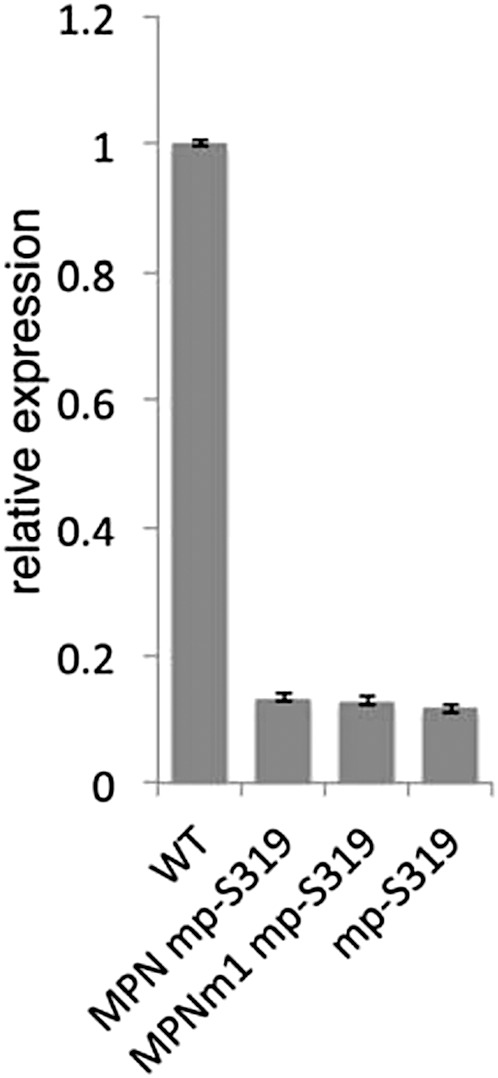
MP message abundance relative to that of EIF4A.MP abundance is similar in mp-S319 and mp-S319 transformed with MPN or MPNm1.